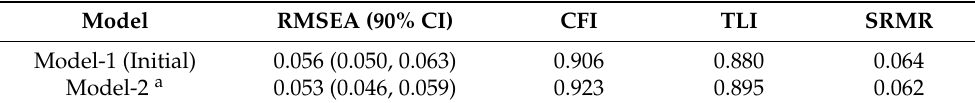
Table 2. Fit Indices for six models in SMS-II.